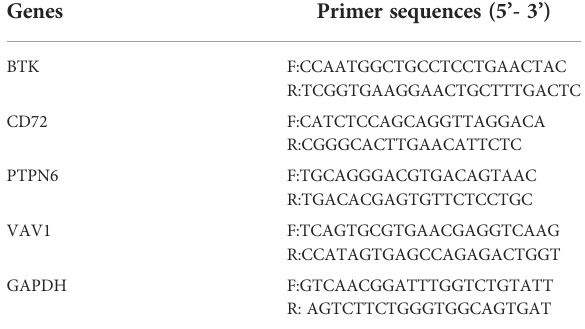
TABLE 1 qRT-PCR